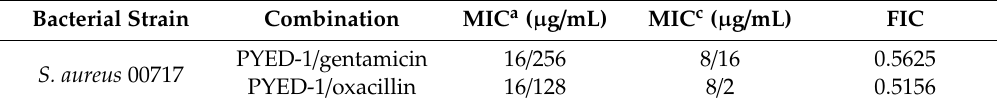
Table 4. Additive e ff ects of the compound PYED-1 with antibiotics against S. aureus .